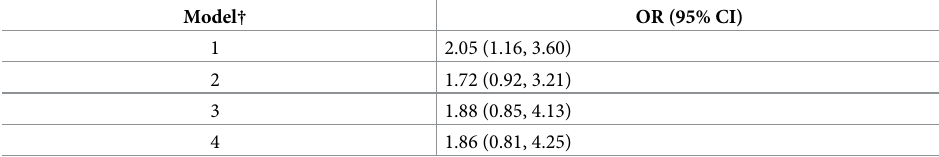
Table 4. Association of AST/ALT > 2 with incident cognitive